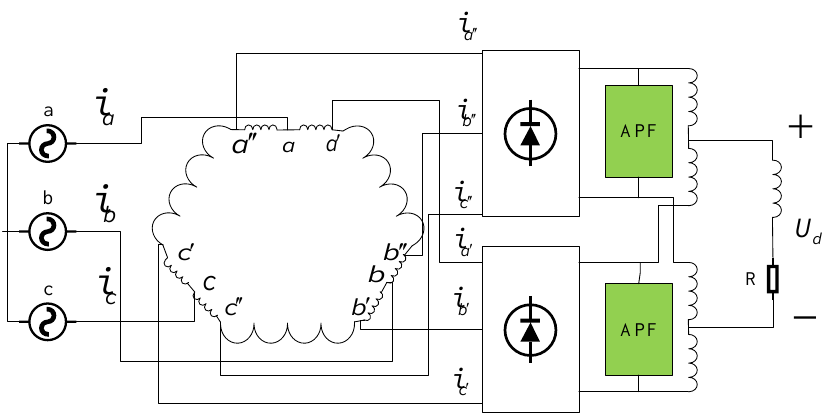
Figure 6. 12-pulse autotransformer rectifier unit with active power filter. It can be seen from Figure 6 that this topology is based on a 12-pulse ATRU, and two parallel APFs are in the output of the three-phase uncontrolled rectifier bridge. Since the input voltages of the two sets of three-phase uncontrolled rectifier bridges have phase difference, their output instantaneous voltages are not equal. In order to ensure normal operation, balanced reactors are used to smooth the two sets of DC voltage, so that the total output voltage meets the working conditions.